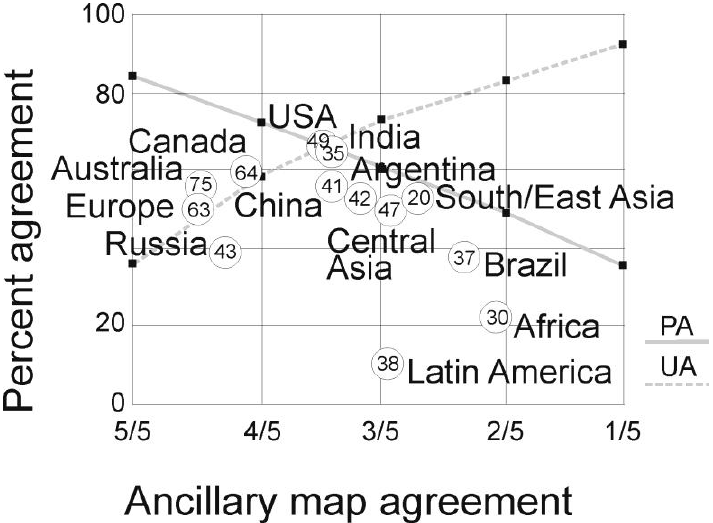
Figure 5. Modeled matching user’s and producer’s accuracies (percent agreement axis) for regions of common agreement amongst five heritage cropland data layers (ancillary map agreement axis). Only the data points for the USA are shown to illustrate the variation of commission and omission errors. Each data point has the probability threshold value independently derived using the FAS PSD database to create the MODIS 250 m cropland